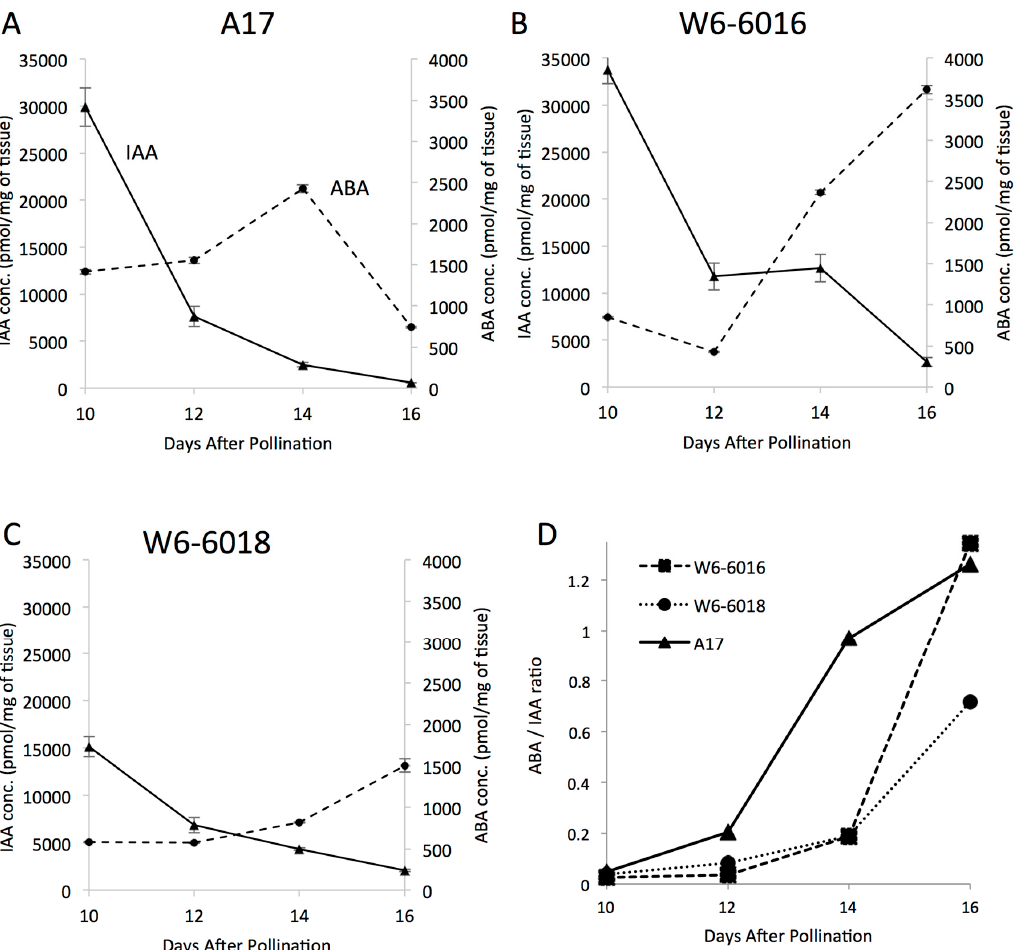
Figure 5. IAA and ABA profiles of the three accessions. ( A – C ) IAA (solid line, Y -axis on the left ) and ABA (dashed line, Y -axis on the right ) levels of A17 ( A ); W6-6016 ( B ); and W6-6018 ( C ) are plotted against the developmental age (DAP) of the seed; ( D ) The corresponding ratios of ABA to IAA from the above figures are plotted against the developmental age of the seeds (DAP) of A17 ( triangles ), W6-6016 ( squares ) and W6-6018 ( circles ). Standard deviations are indicated in the different panels.